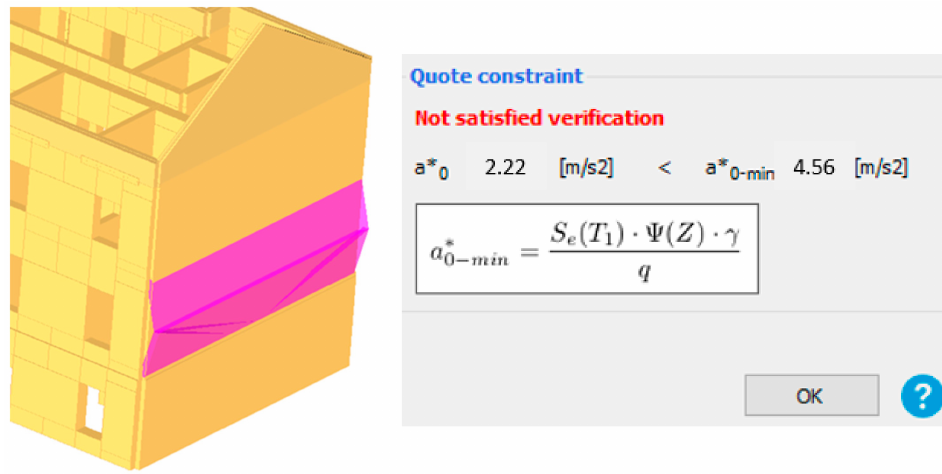
Figure 23. Local mechanism LM2 (Southern wall of the 2nd floor).